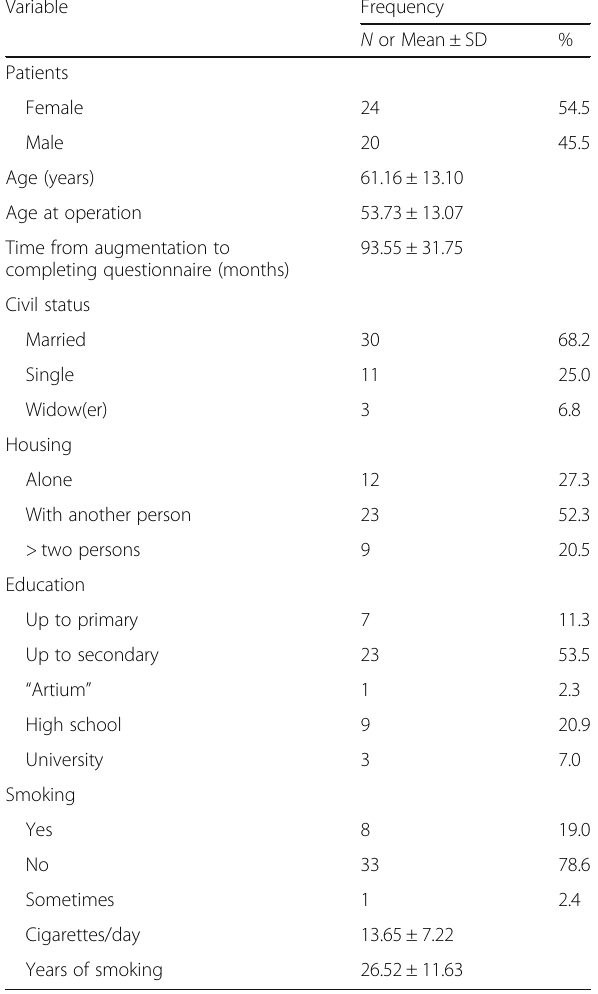
Table 2 Patients ’ demographic and lifestyle-related data